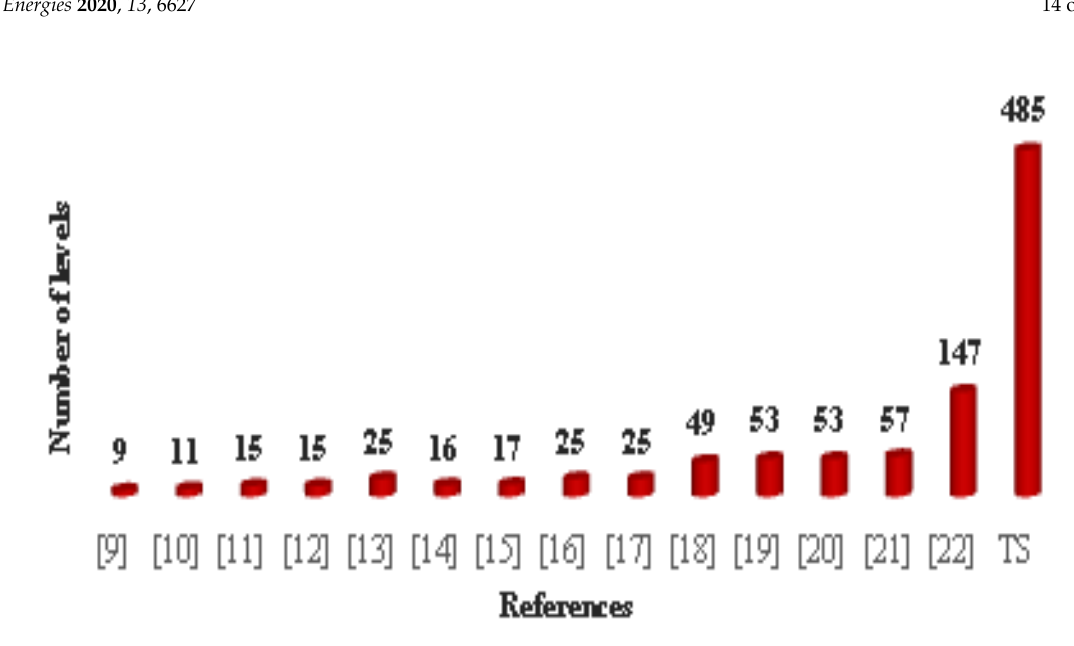
Figure 8. Comparison in terms of the number of voltage levels.